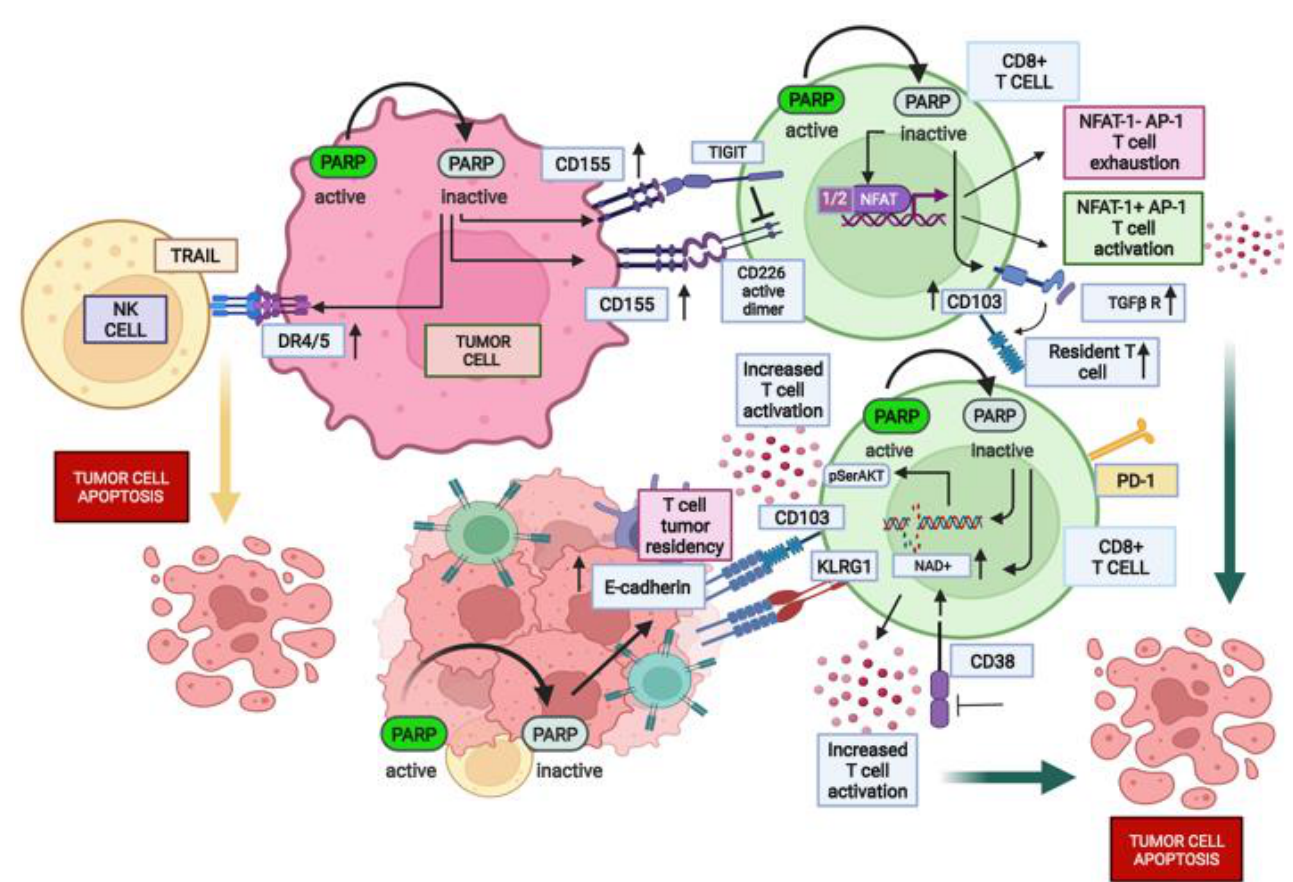
Figure 2. Identification of potential new targets of PARPi. Potential interference of PARPi with different features involved in anti-tumor immune response. PARPi can potentially increase: (i) expression of CD155, the ligand of both CD226 and TIGIT, interfering with the competition between co-stimulation and co-inhibition provided by these molecules; (ii) DR4/5, thus increasing the susceptibility to NK-mediated apoptosis through the engagement of TRAIL. PARPi can differently regulate the various forms of NFAT, affecting activation and/or exhaustion of T cells (see text), and can potentially induce the expression of T β R, stimulating the generation and intra-tumor permanence of Tres. Inhibition of PARP, by producing DNA damage, can favor the CD8+ T cell function by activating AKT. See text for further details. “Created with BioRender.com.”